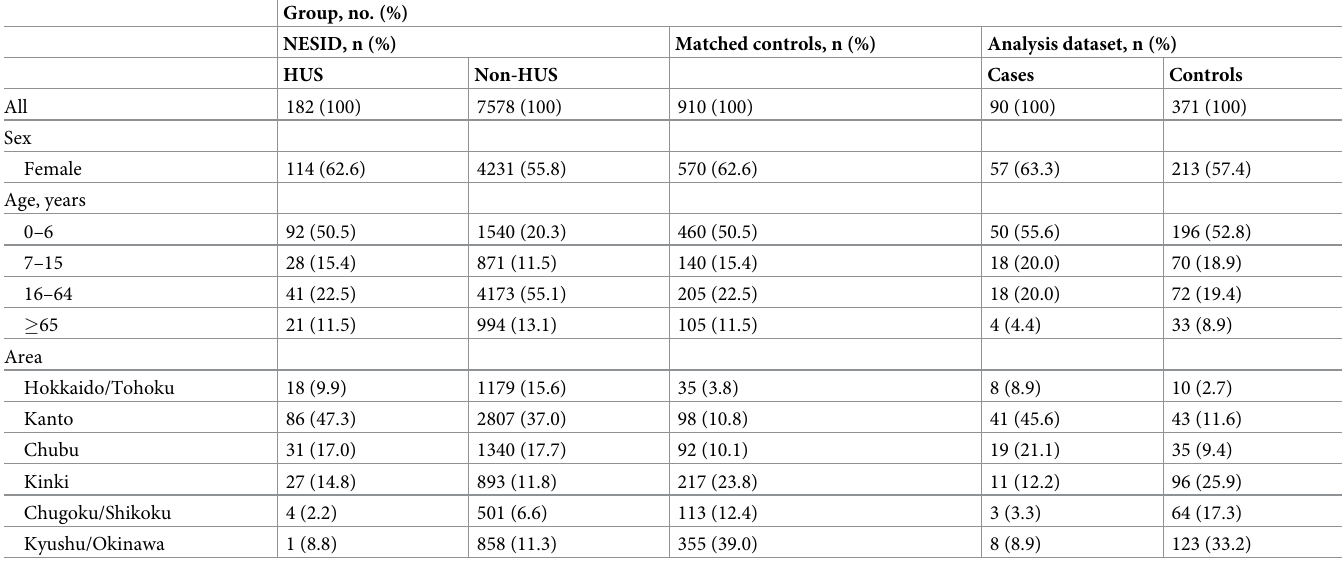
Table 1. Baseline characteristics of the NESID cohort, matched controls, and cases and controls included in the main analysis. Group, no.